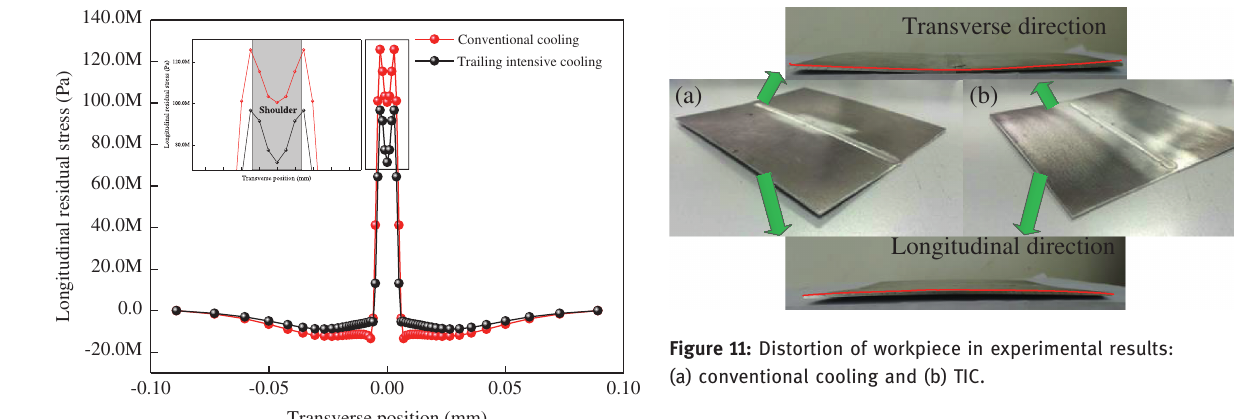
Figure 10: Distribution of longitudinal residual stresses of workpiece.